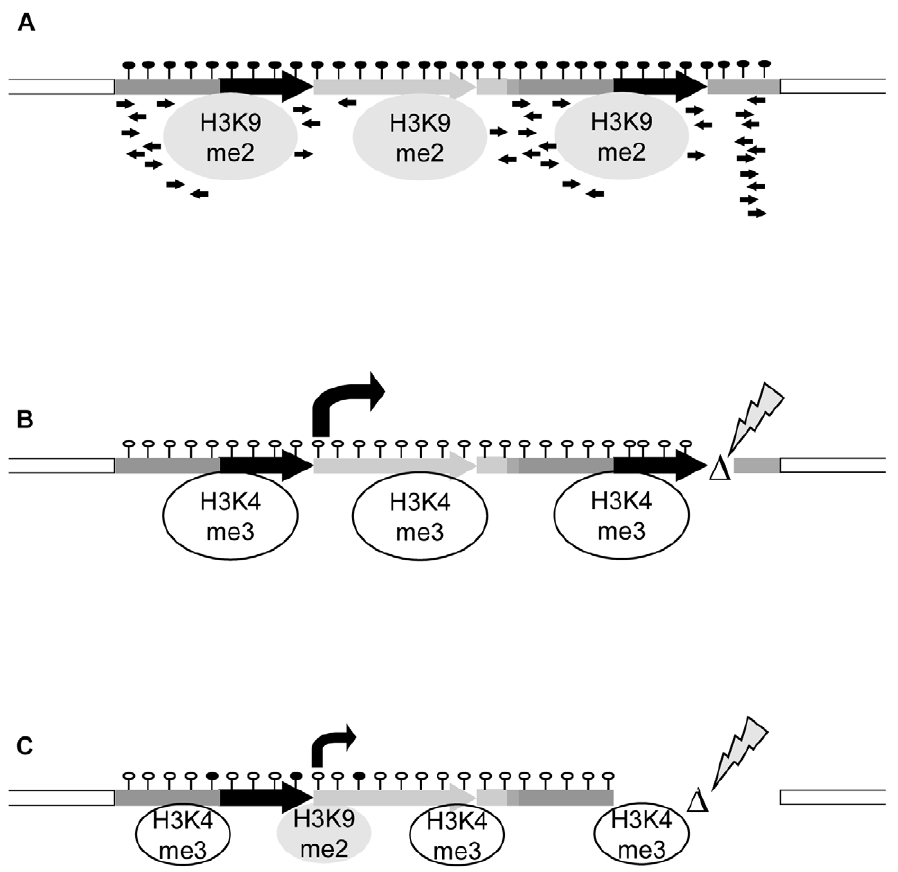
Figure 6. Model for transcriptional regulation of epialleles. (A) The silent state is maintained by interplay of DNA hypermethylation, repressive histone modifications, lack of activating marks, presence of sRNAs and structure of the controlled gene, all mutually reinforcing the block of transcription. (B,C) Release of silencing can occur after structural rearrangements. (B) Even minor changes, like in cis- mutant R D 4, can trigger a switch to high transcript levels, drastic changes of chromatin features and stable genetic transmission. (C) A major rearrangement like in cis- mutant R D 1, although deleting the sRNA-producing region, does not necessarily result in stable switches. Transcript levels are lower; exchange of histone marks is incomplete and not stable in subsequent generations. This points to a significant role of sequence or gene structure, possibly by different secondary structure or nucleosome positioning, in stability of epialleles.